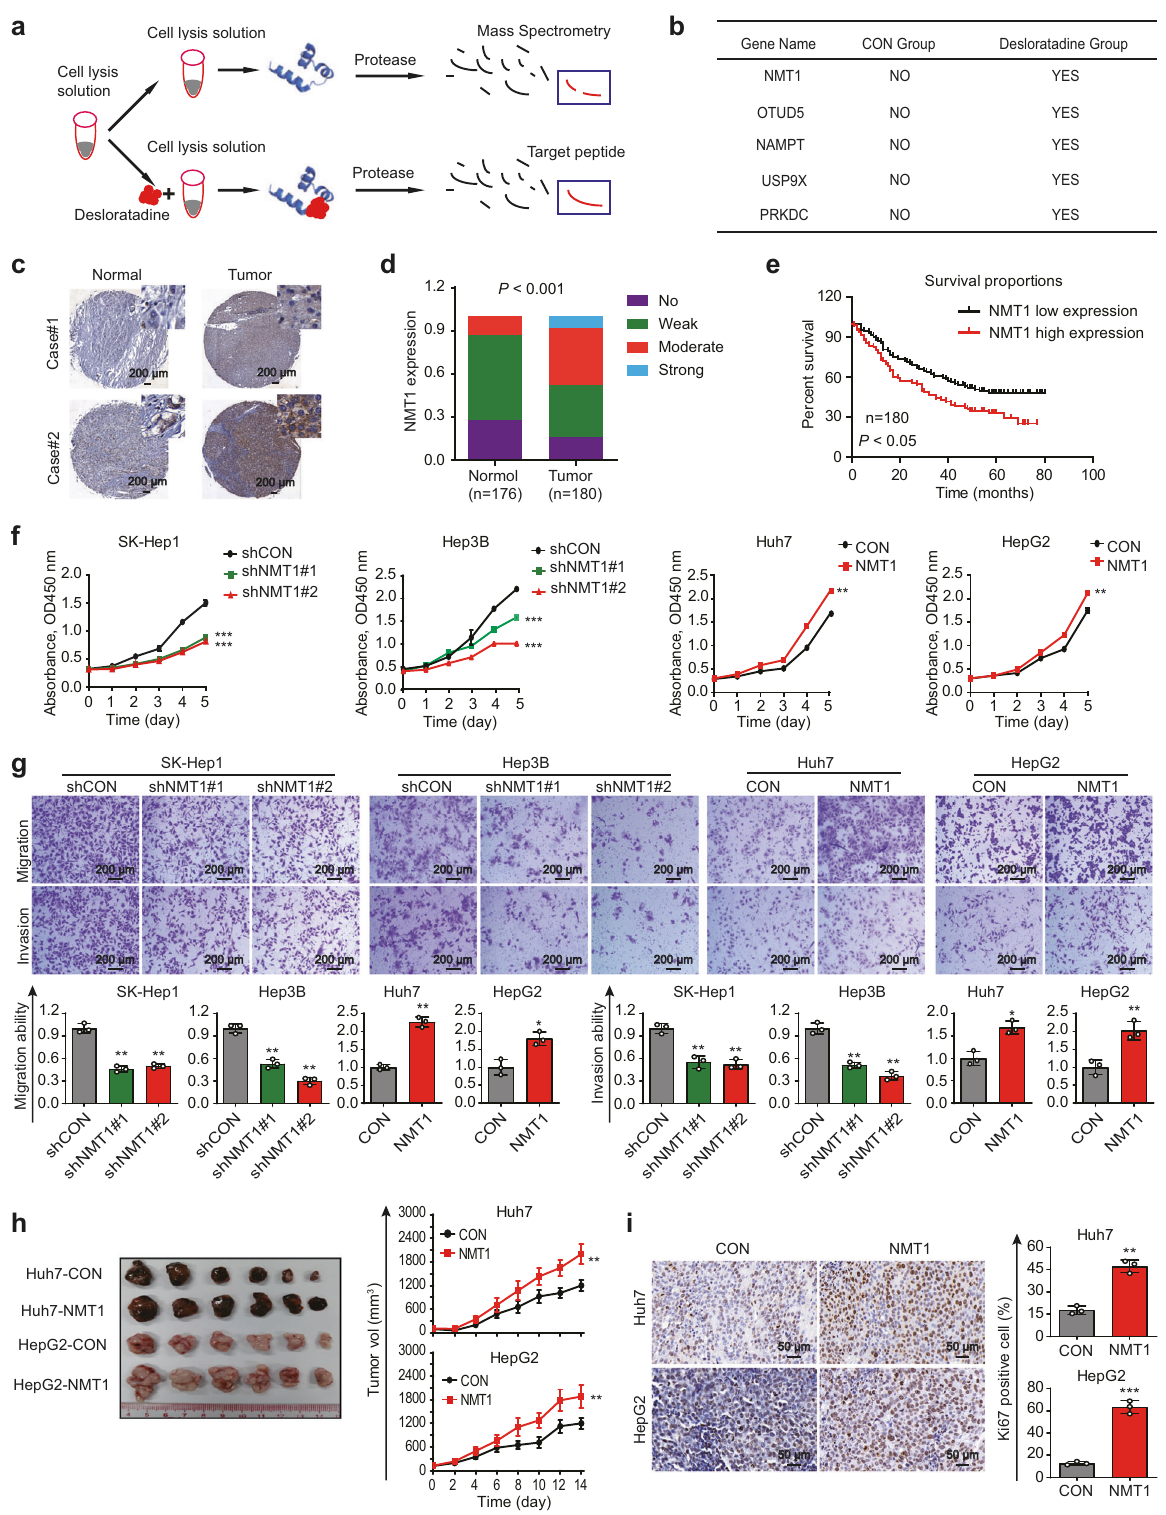
Fig. 2 Desloratadine targets the NMT1 protein, which contributes to the progression of HCC. a Schematic diagram of the DARTS method. b The 5 candidate proteins identi fi ed by mass spectrometry analysis. c IHC staining showing NMT1 expression in clinical HCC tissues and adjacent noncancerous tissues. d NMT1 expression in 180 HCC tumor tissues and 176 matched nontumor tissues. e The NMT1 expression level was signi fi cantly negatively correlated with the overall survival rate of HCC patients (low NMT1 expression: No and Weak; high NMT1 expression: Moderate and Strong). f Cell viability assay showing the effect of NMT1 expression on the viability of HCC cells. g Effects of NMT1 expression on the migration and invasion of HCC cells. h Image of subcutaneous xenografts derived from nude mice ( n = 6 tumors per experimental group) and xenograft growth curves. i Representative images of Ki67 staining in tumor tissue. Bars, SDs; * p < 0.05; ** p < 0.01, *** p < 0.001 Signal Transduction and Targeted Therapy (2023)